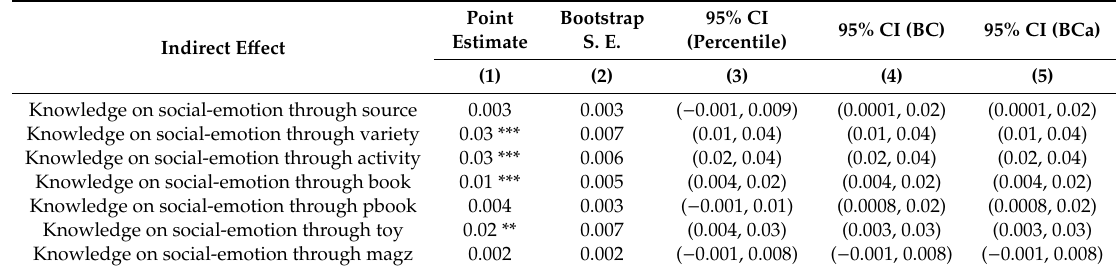
Table 7. Estimates of indirect e ff ects of parenting knowledge on social-emotional development through di ff erent parental